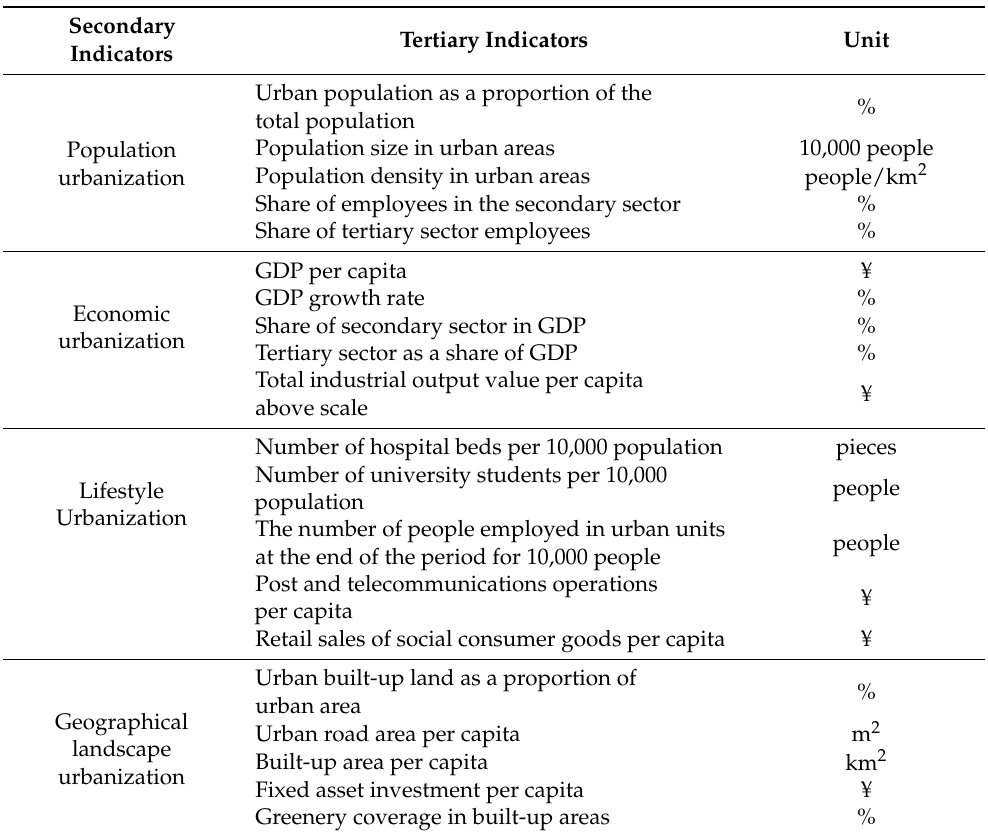
Table 3. Comprehensive evaluation index system of urbanization